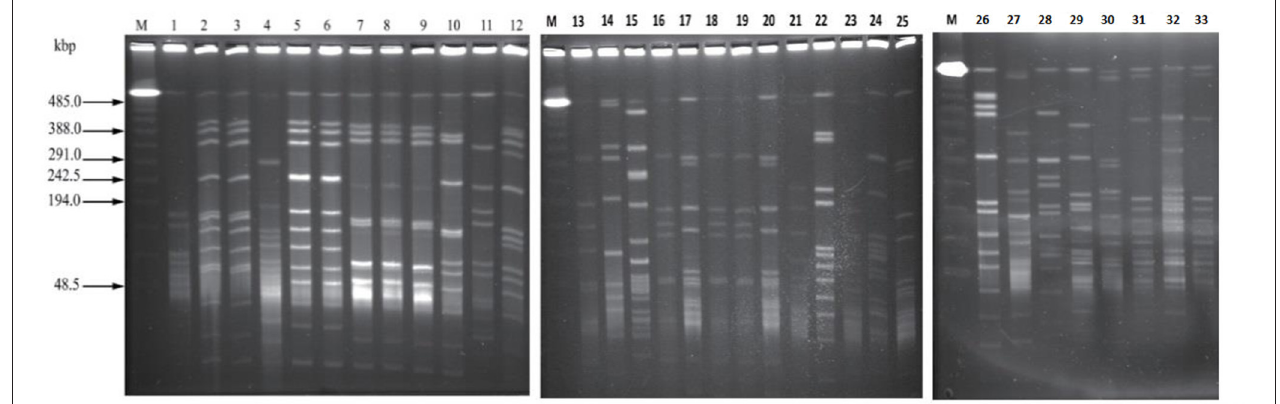
FIGURE 6 | The pattern obtained by PFGE SmaI, Marker = (PFGE Lambda Marker New England Bio, UK) lanes: 1–33 strains of C. perfringens of bovine origin showing different DNA macrorestriction